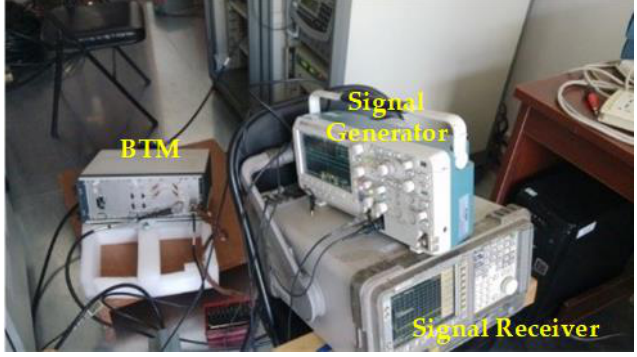
Figure 13. The setup of the test for getting h .